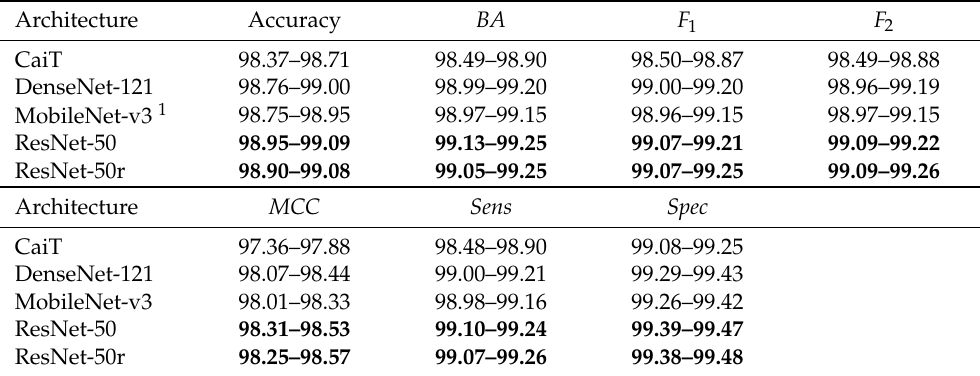
Table 9. Confidence intervals by architecture after 1000 bootstrapping cycles with α = 0.05. Best results are highlighted in